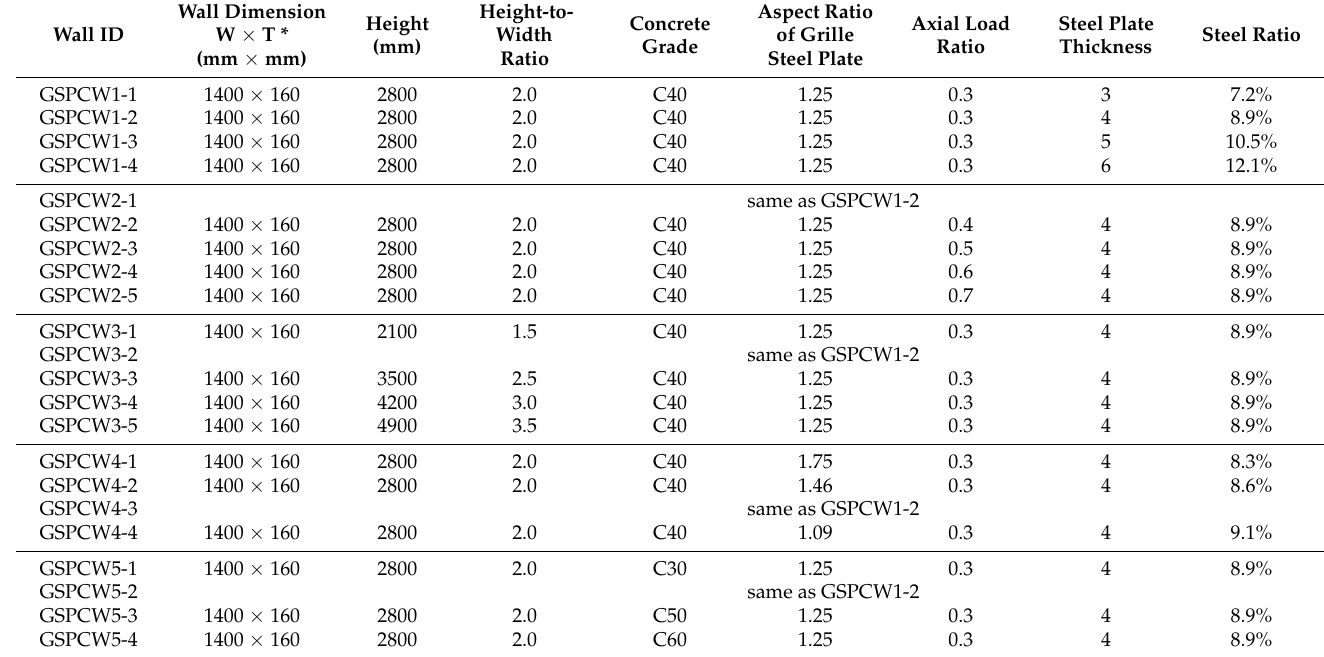
Table 3. Parameter variations for numerical parametric